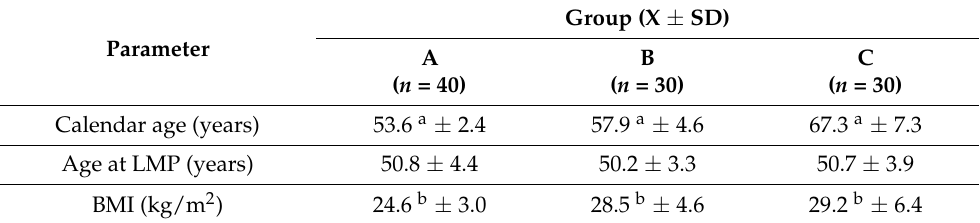
Table 1. Comparison of calendar age, age at the last menstrual period and body mass index in the study